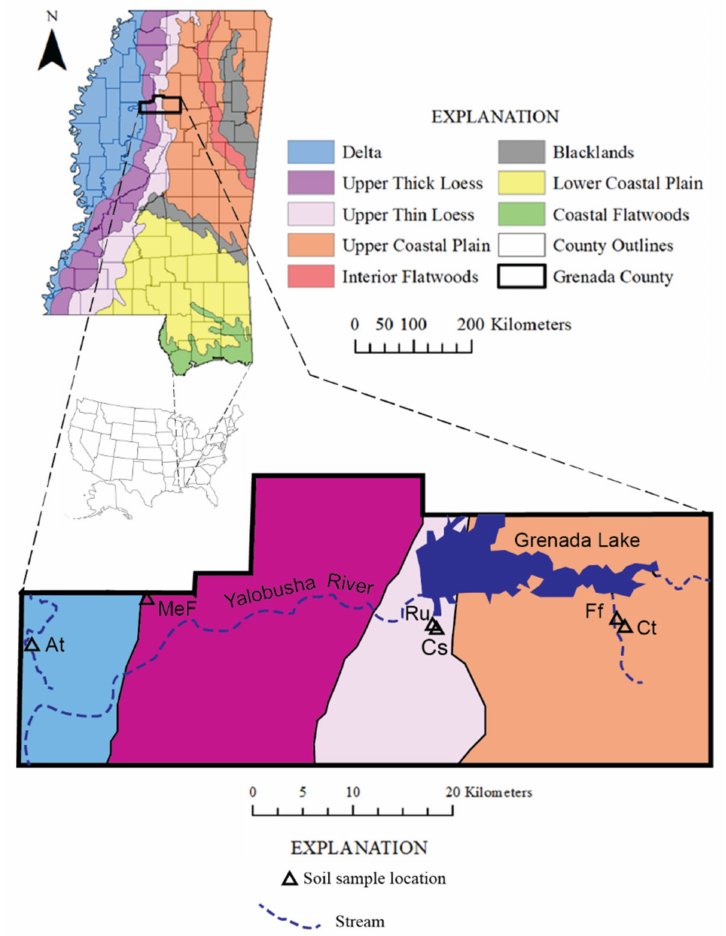
Figure 1. Locations of study area and land resources areas (modified from Vanderford [45]) in Mississippi, USA, and sample collection sites. Soil and sediment abbreviations are At, Alligator Association; Cs, channel sand; Ct, Cuthbert Series (Ct1, A horizon; Ct2, B horizon); Ff, Falaya Silt Loam Series; MeF, Memphis Silt Loam Series; Ru, Ruston Series (Ru1, A horizon; Ru2, E